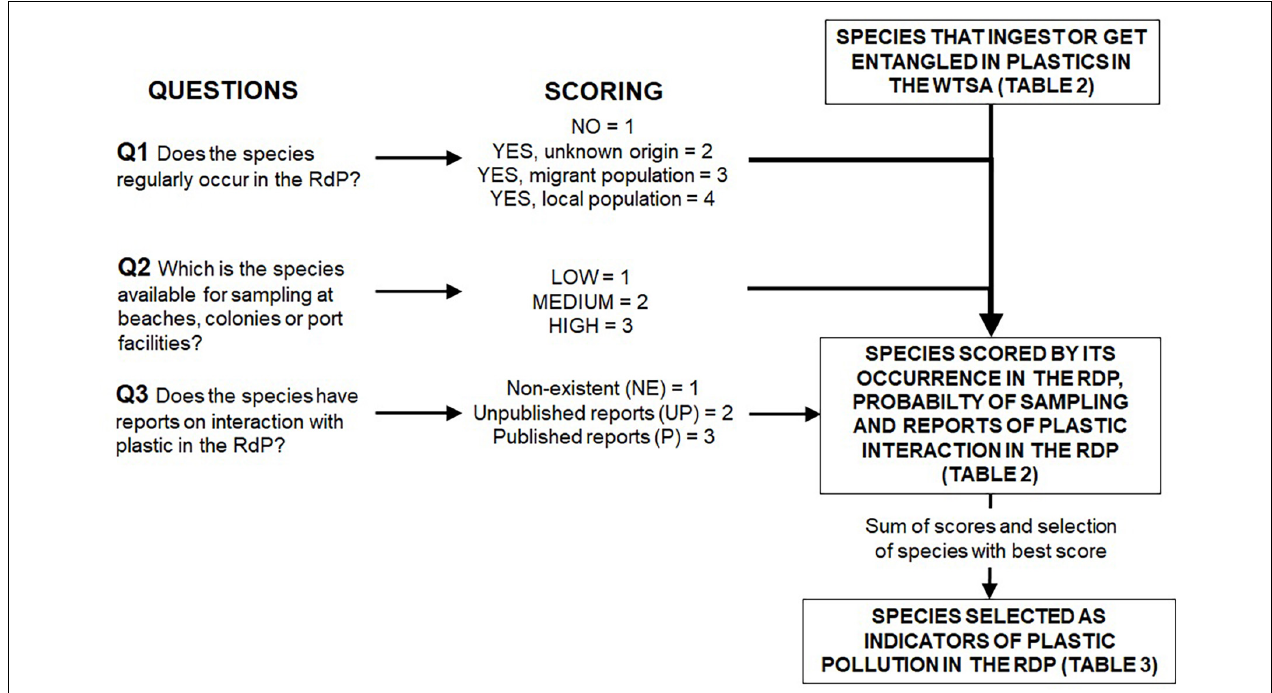
FIGURE 2 | Three-question structured scheme for selecting charismatic marine species as indicators of plastic pollution in the Río de la Plata estuarine area.